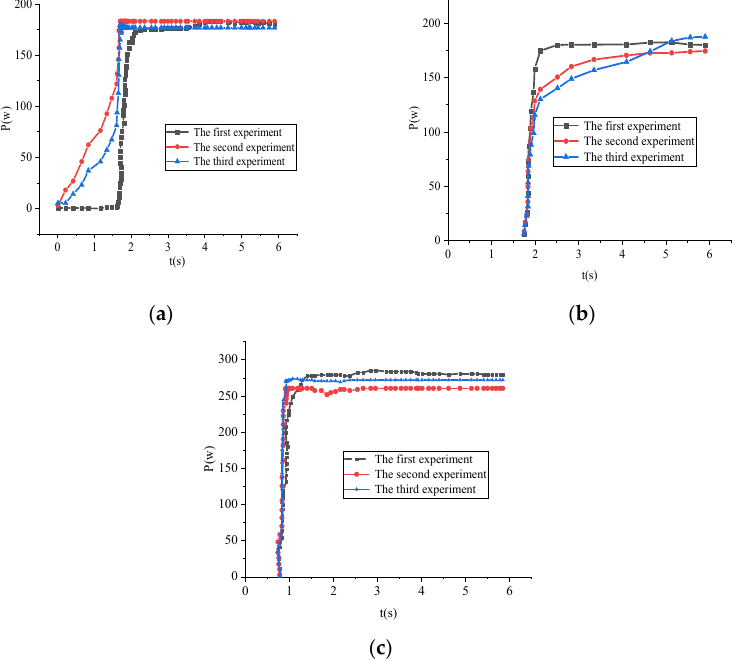
Figure 8. Experimental results of the photovoltaic MPPT control systems ( a ) TPOM; ( b ) IAM; ( c ) AOA-PSO.